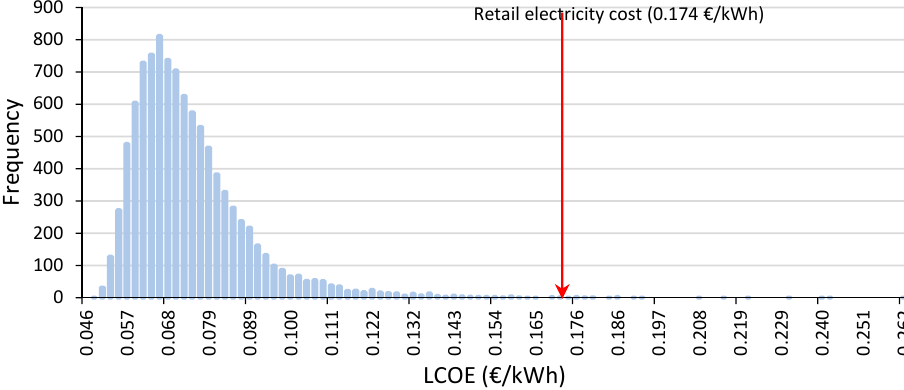
Figure 17. Histogram of the LCOE calculated with the Monte Carlo method for a 500 kW system.